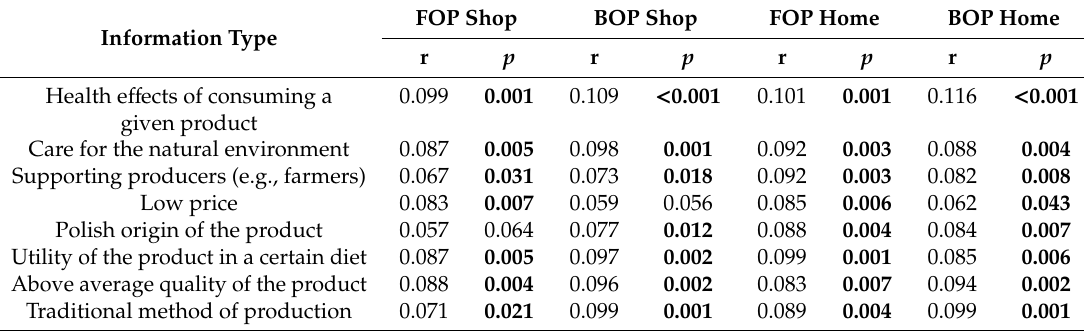
Table 17. Pearson correlation coe ffi cients of reading food labels with the subjective importance of selected information types in the marketing communication for food products.